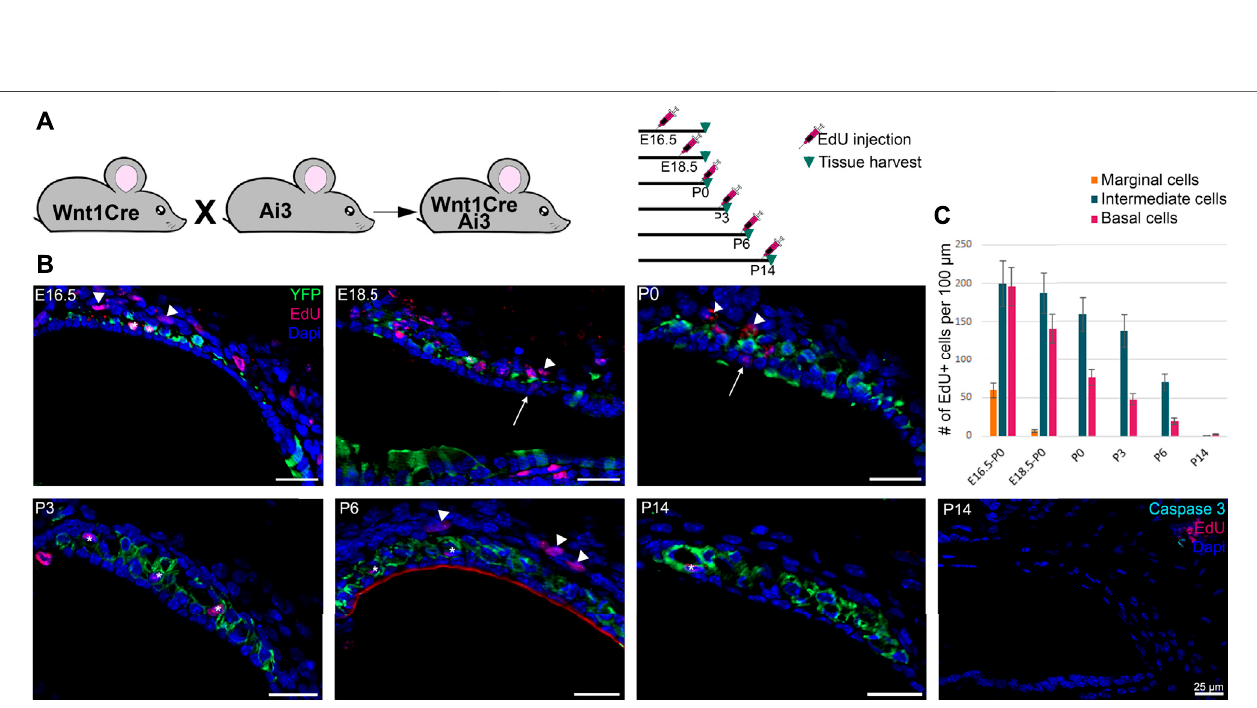
FIGURE 2 | Intermediate cells in the developing stria vascularis follow a base-to-apical gradient of ingression and undergo morphological maturation at early postnatal days. (A) Immunostaining of E16.5 Wnt1cre-YFP mouse with white dashed square magni fi ed in insets. Future intermediate cells migrate (arrows) then line up on top of the cochlear duct and ingress in the lateral wall of the cochlea following a basal to apical gradient. CD44 (in red) is a cell membrane marker of melanoblast that shows the protrusion in the marginal cells layer (Arrowheads). 1: apex, 2: mid apex, 3: mid base, 4: base. (B) Schematic representation of the base to apex semi- ingression process. Melanoblast are represented in dark pink at the surface of the lateral wall. (C). Immunostaining of P0, P6 and P32 Wnt1Cre-YFP mouse with white dashedsquaremagni fi edininsets.GreencellsinthestriavascularisareintermediatecellslabeledbyWnt1-CRE2crossedtoaEYFPreporter.KCNQ1andConnexin26, markers of marginal and basal cells respectively, are both in purple to delimit the intermediate cell region in the stria vascularis.